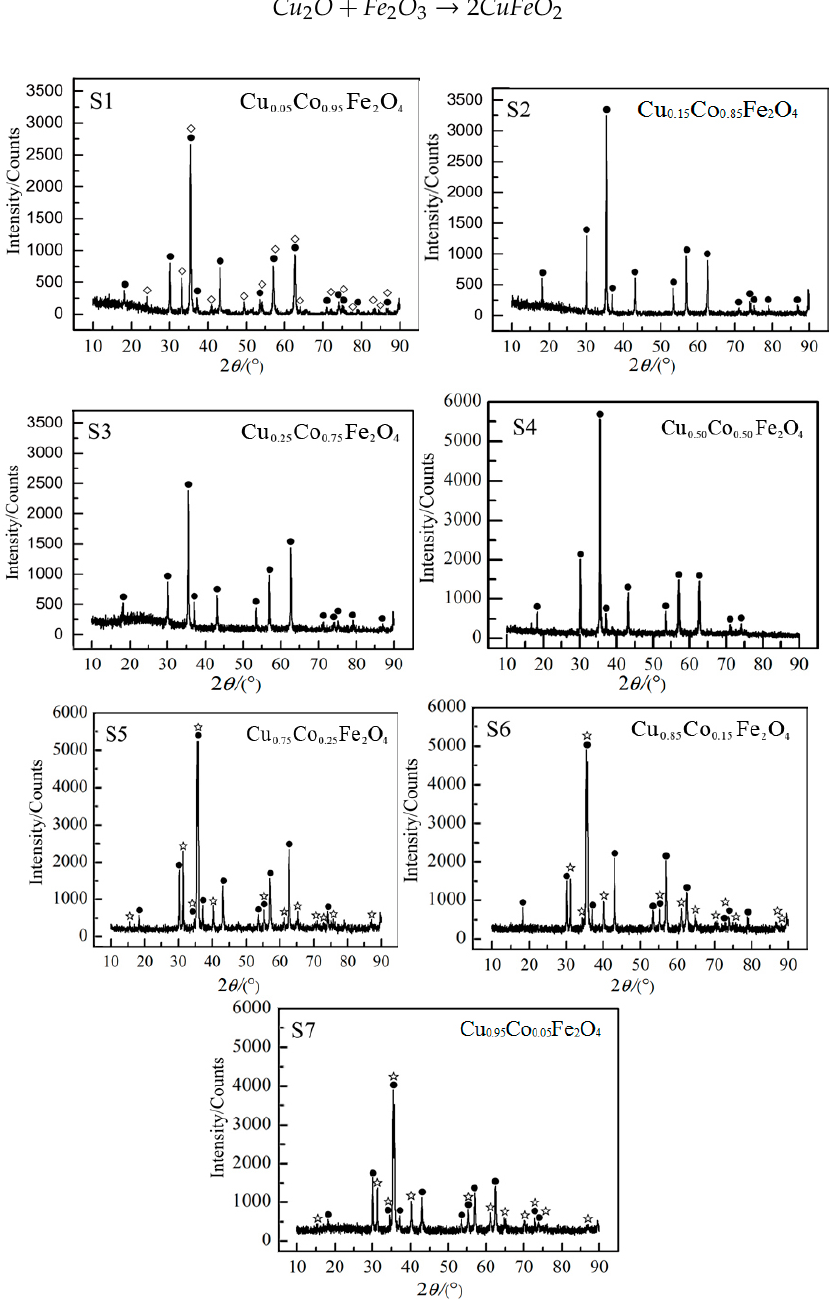
Figure 3. XRD pattern of the sample. The symbols • , and (cid:73) represent spinel, Fe 2 O 3 and delafossite, (cid:51) respectively. Cu 0.05 Co 0.95 Fe 2 O 4 (S1); Cu 0.15 Co 0.85 Fe 2 O 4 (S2); Cu 0.25 Co 0.75 Fe 2 O 4 (S3); Cu 0.50 Co 0.50 Fe 2 O 4 (S4); Cu 0.85 Co 0.15 Fe 2 O 4 (S5); Cu 0.95 Co 0.05 Fe 2 O 4 (S6); Cu 0.75 Co 0.25 Fe 2 O 4